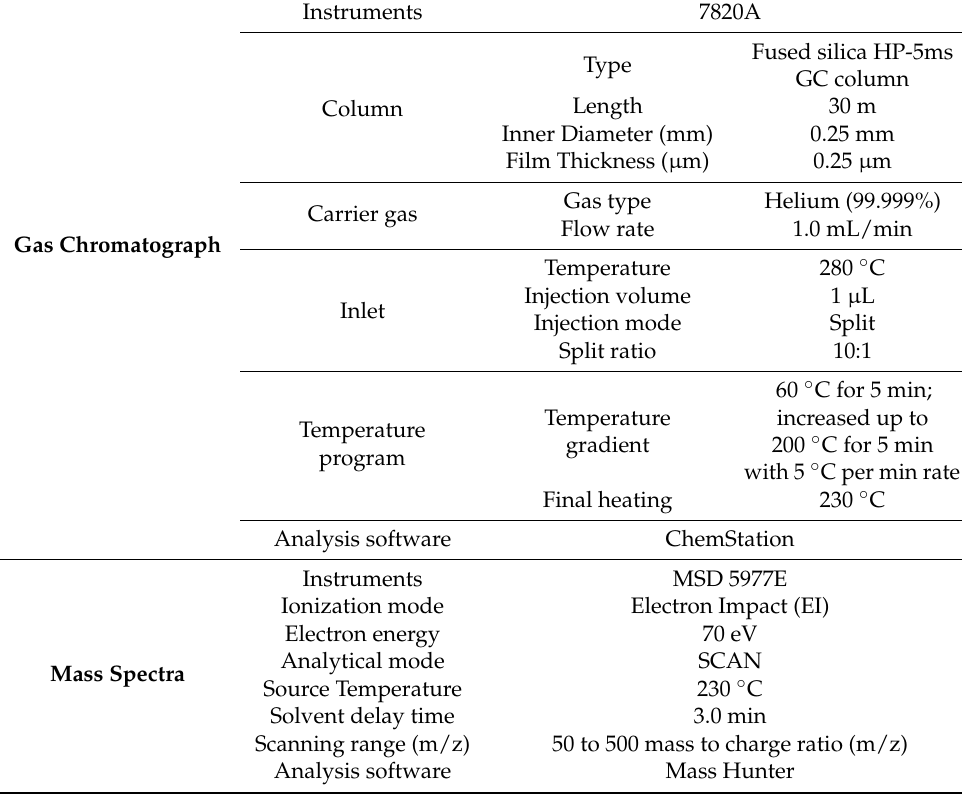
Table 1. Gas chromatography and mass spectra (GC-MS)